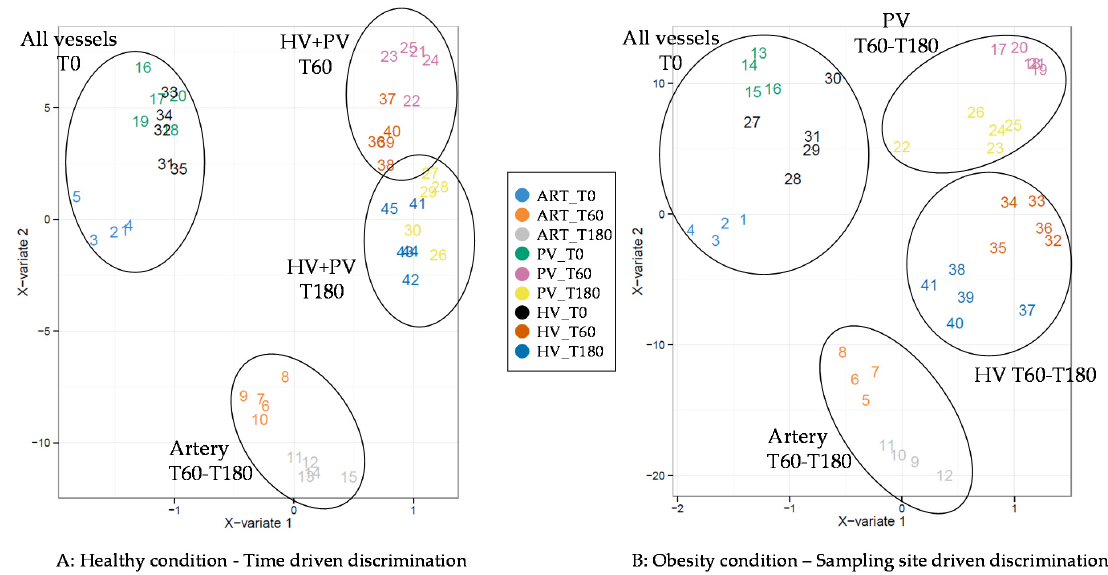
Figure 2. Scores plot of multi-level sparse partial least squares discriminant analysis model ( n = 5) after OSC filter. Analyses were done at the healthy ( A ) and obese ( B ) conditions. Analyses were focused on the T0, T60, and T180 min. ART, artery; PV, portal vein; HV, hepatic vein.